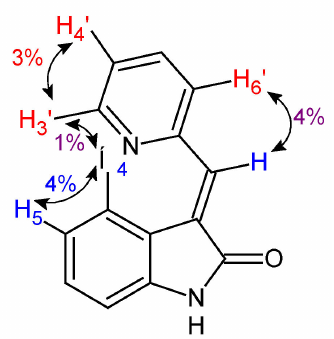
Figure 2. NOE correlations for E -isomer of compound 1